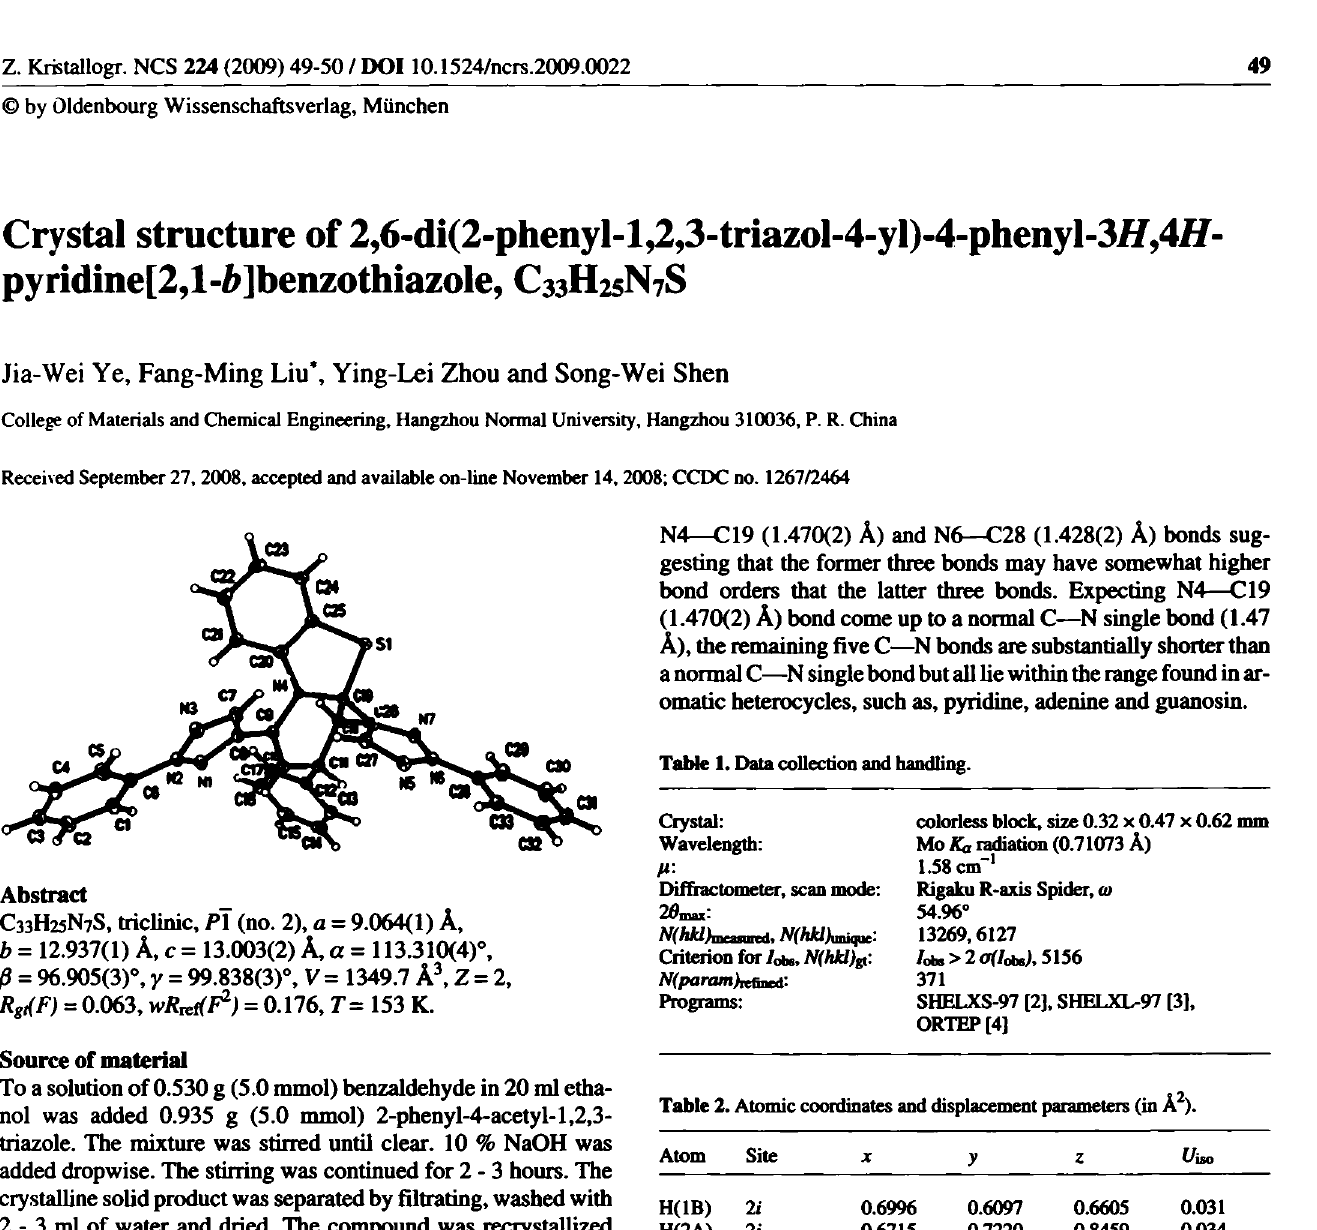
Table 2. Atomic coordinates and displacement parameters (in Â 2